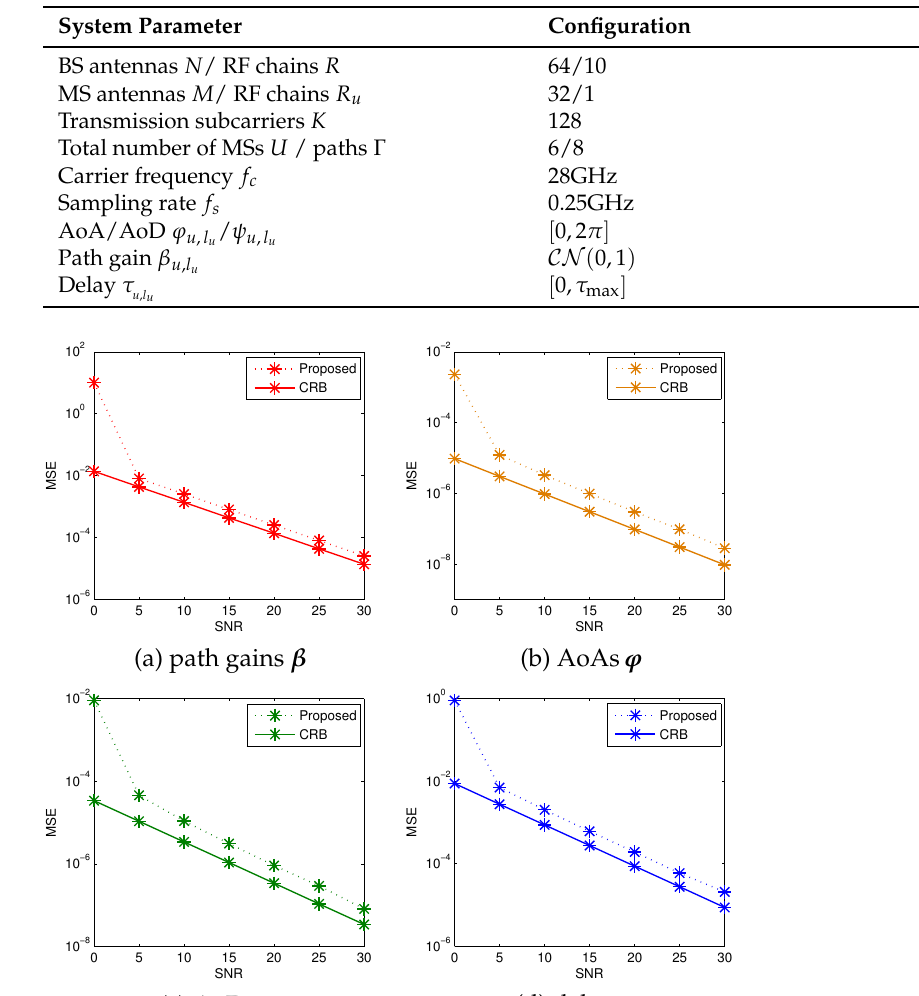
Table 3. Simulation configuration of system parameters.